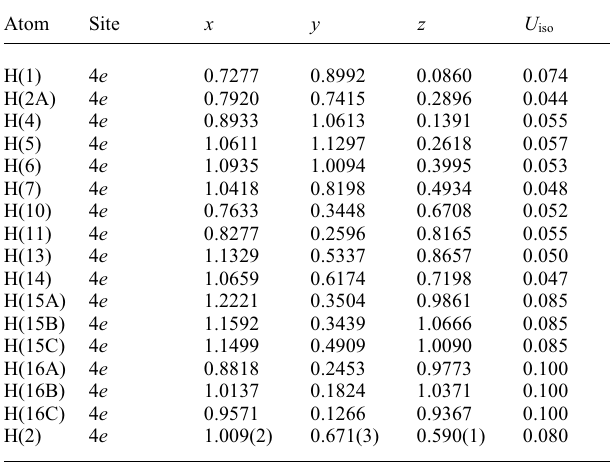
Table 2. Atomic coordinates and displacement parameters (in Å 2 )